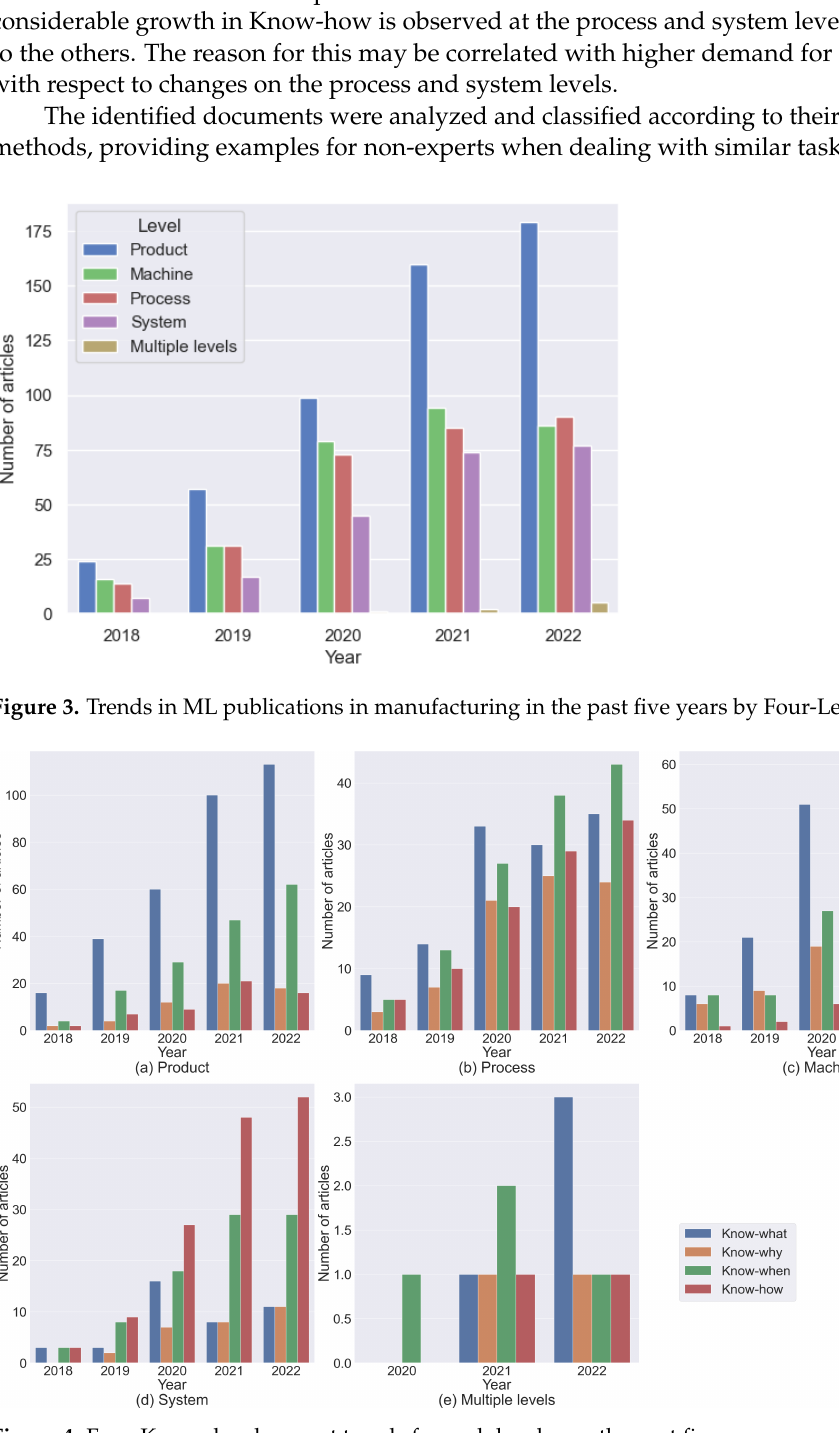
Figure 4. Four-Know development trends for each level over the past five